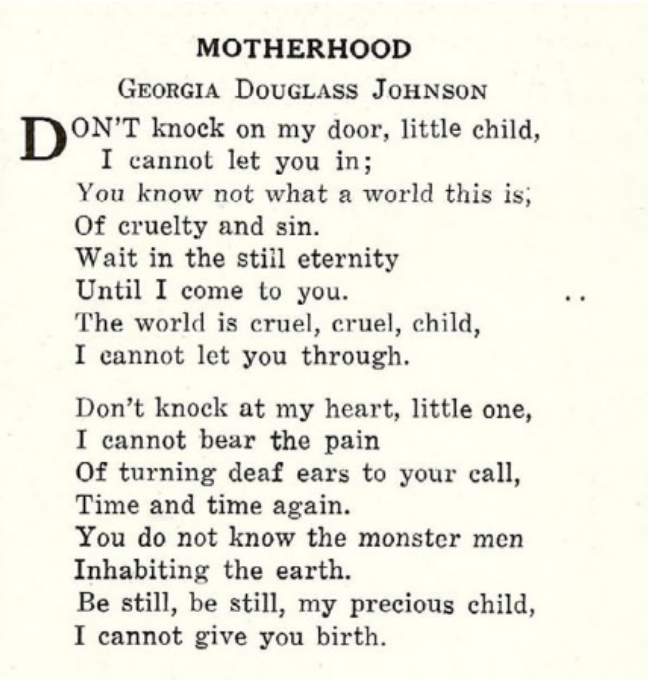
Figure 3. First published in the 1922 Children’s Number bearing the title “Motherhood,” Johnson would revise the title of this poem for publication in her second book of poems, Bronze , in which it appears as “Black Woman.” The Crisis October 1922, 24.6, p. 265, The Modernist Journals Project, https://modjourn.org/issue/bdr521702/, (accessed on 30 May 2022).